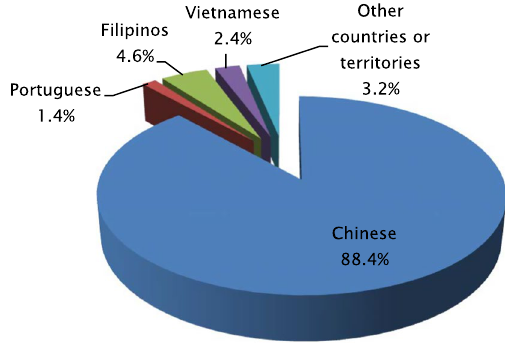
Fig. 1 The Chinese and non-Chinese population of Macau in 2016 (DSEC, 2017)